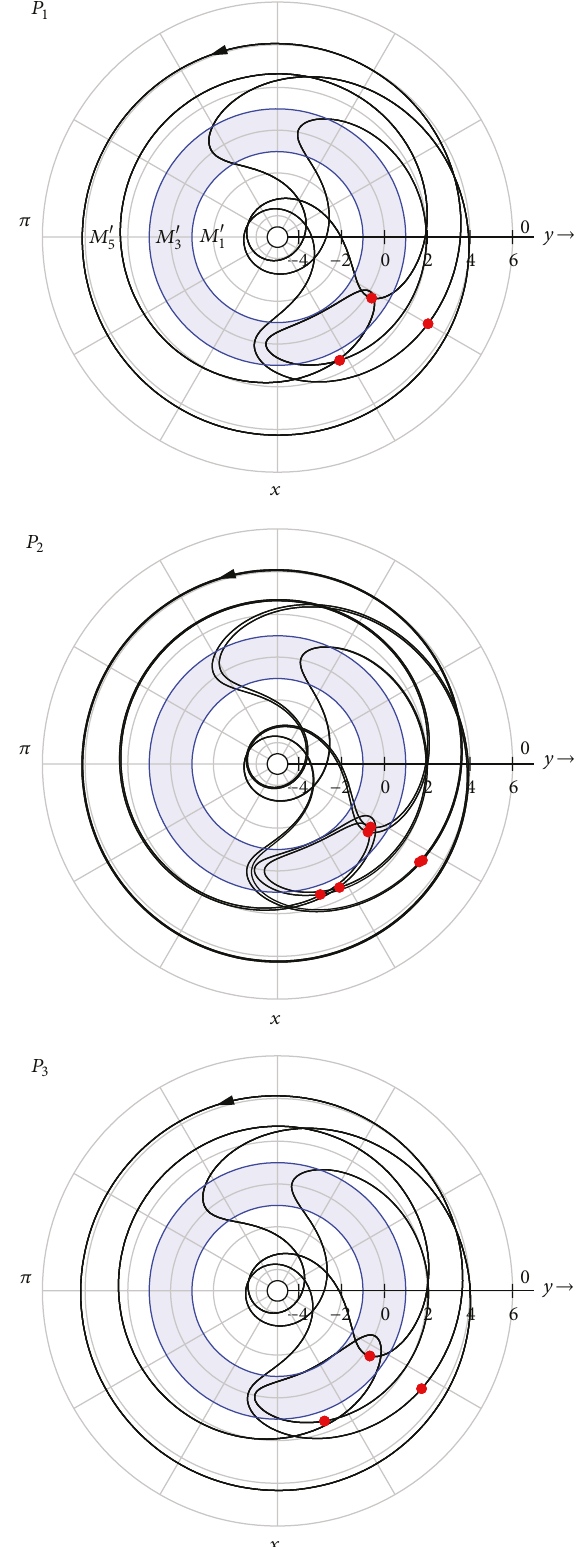
Figure 9: Trajectories of system (3) with 𝑓(𝑦) = 𝑓 2 (𝑦) . The parameters and initial conditions are in (20) and 𝑃 1 : (𝐵 0 , 𝐵) = (1.45,1.60) , 𝑥 = (−0.522,3.126) , 𝑃 0